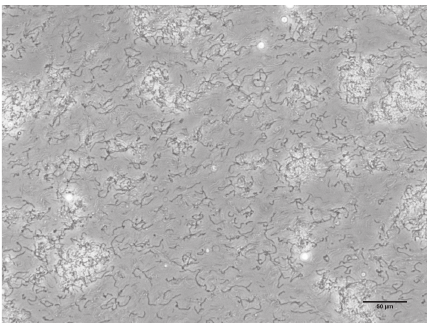
Figure 6: Microscopy view of the M. thermautotrophicus culture. The filamentous morphology of the methanogens remained vastly abundant; however, small microbial contaminants were observed. The bar is equal to 50 𝜇